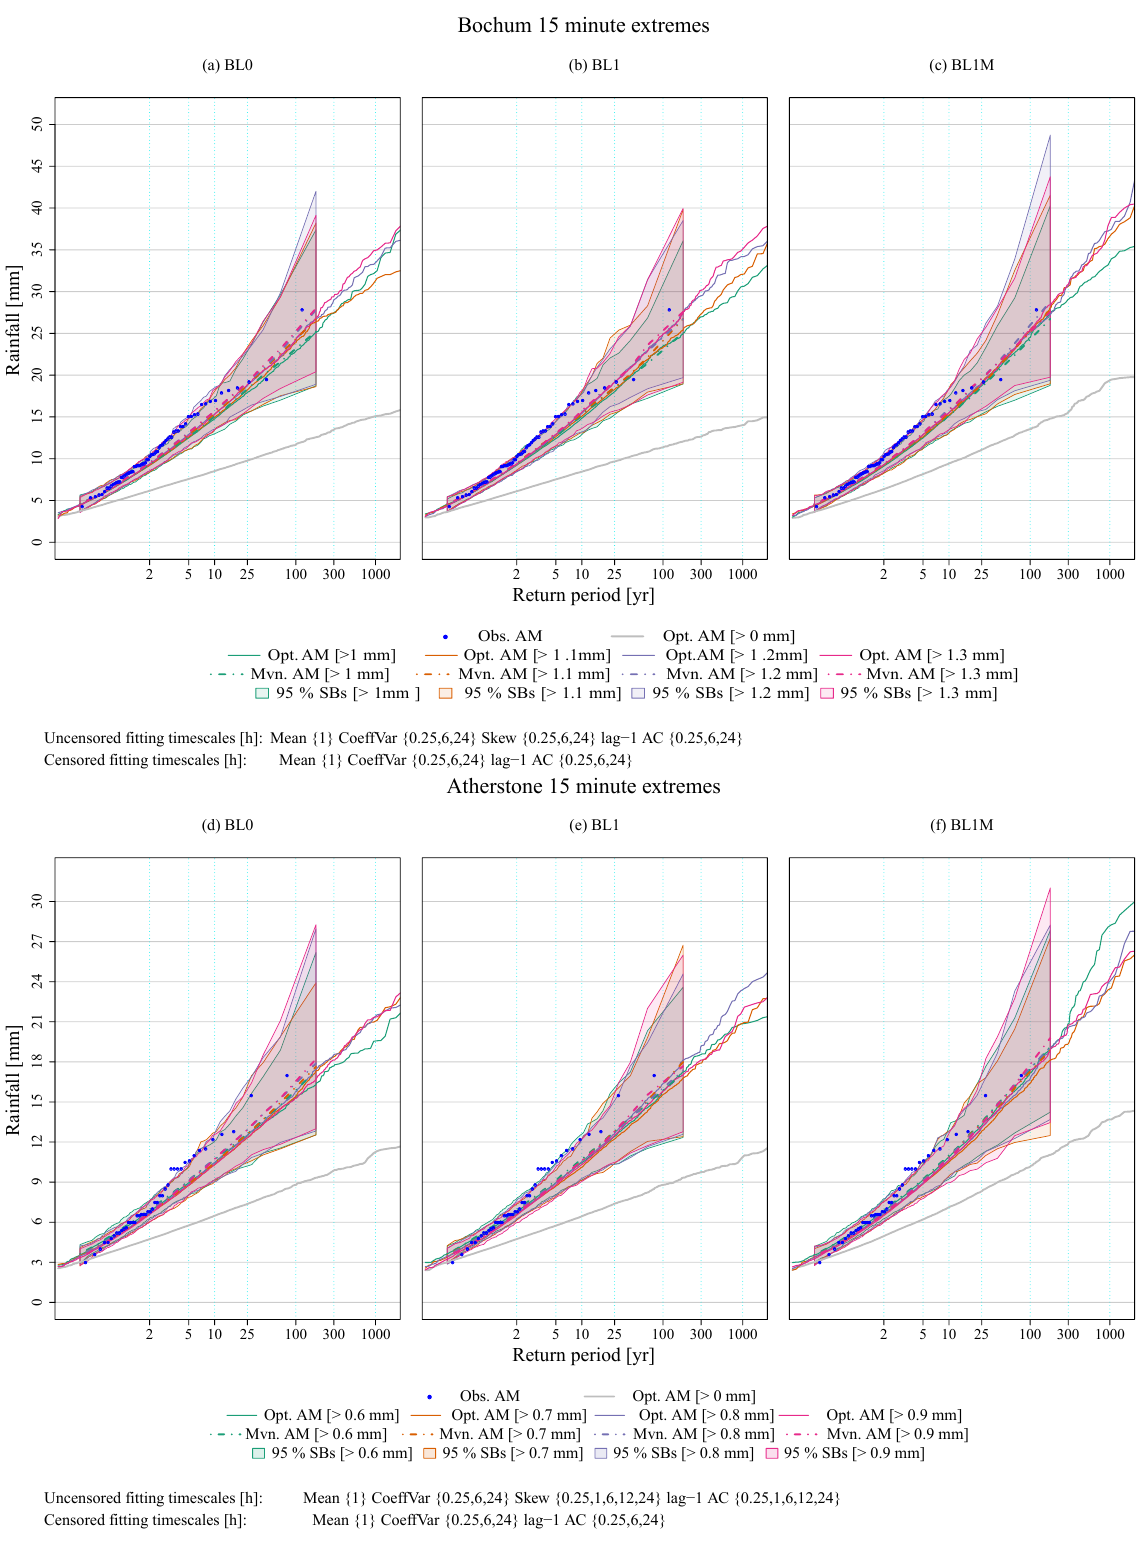
Figure 5. Extreme value estimation at 15min resolution. Optimal realizations (opt. AM) are shown with solid lines and the means of the MVN realization (mvn. AM) are shown with dashed lines. Simulation bands (SBs) are shown with filled